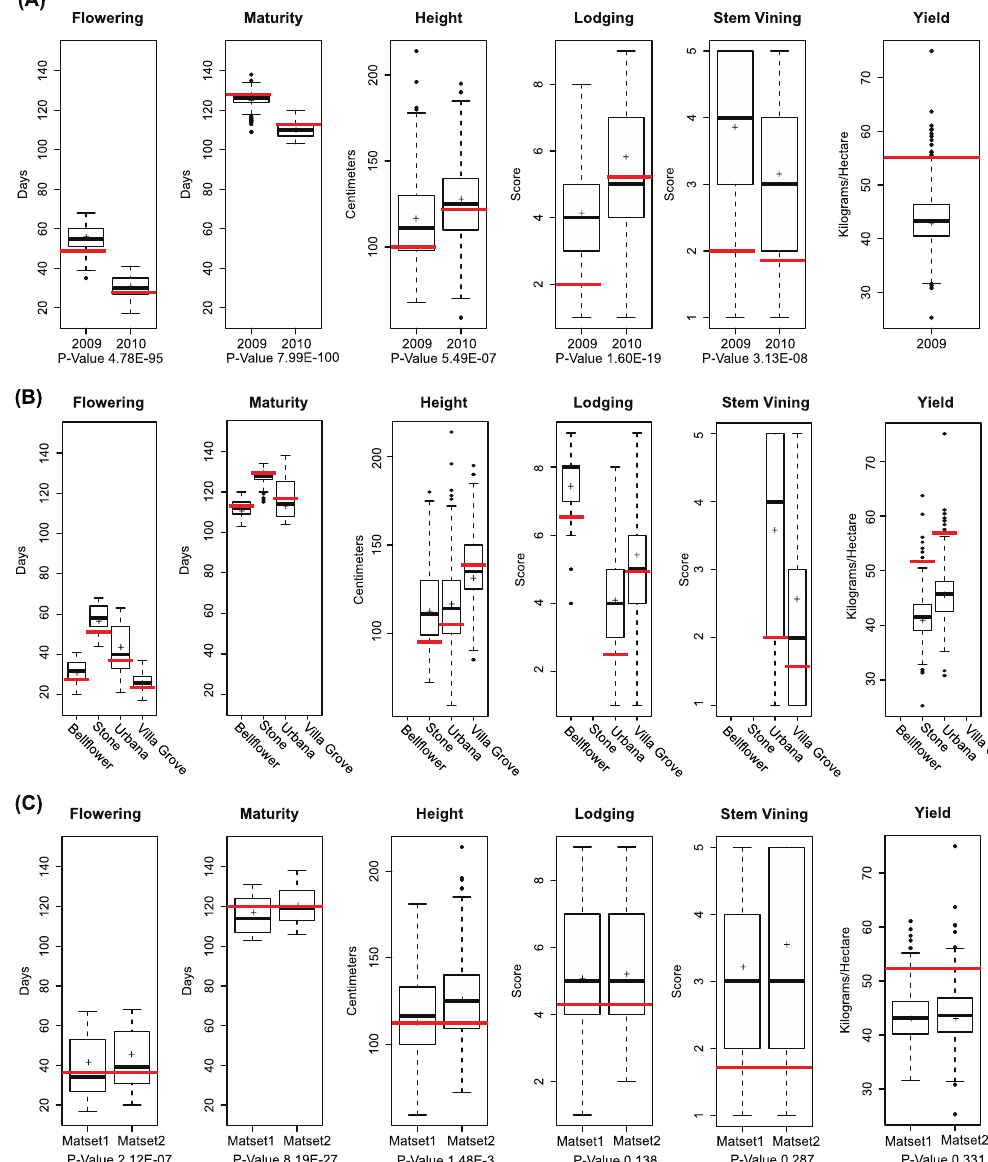
Figure 2. Phenotypic distribution in the 115 BC2F6 RIL population by year and by maturity set. ( A ) Phenotypic distribution in 2009 and 2010 (n = 115). Yield was measured only in 2009. ( B ) Phenotypic distribution at Bellflower, Stone, Urbana, and Villa Grove field locations. ( C ) Phenotypic distribution in the early maturity group (Matset1; n = 64) and the late maturity group (Matset2; n = 51). The box indicates the interquartile range, and black circles represent outliers. The black horizontal line indicates the distribution median and the cross indicates the distribution mean. The red horizontal line represents the mean of Williams 82. P-values were obtained using a Student’s T-test. Flowering shows the time when 50% of the plants have at least one flower on any node (R1), and maturity shows when 95% of the seed pods reach full mature color (R8). Lodging is shown in 1–10 scales where 1 represents Williams 82 and 10 reflects lodging in the G. soja parent. Vining is shown in 1–5 scales where 1 is no vining as in Williams 82 and 5 is vining represented by the G. soja